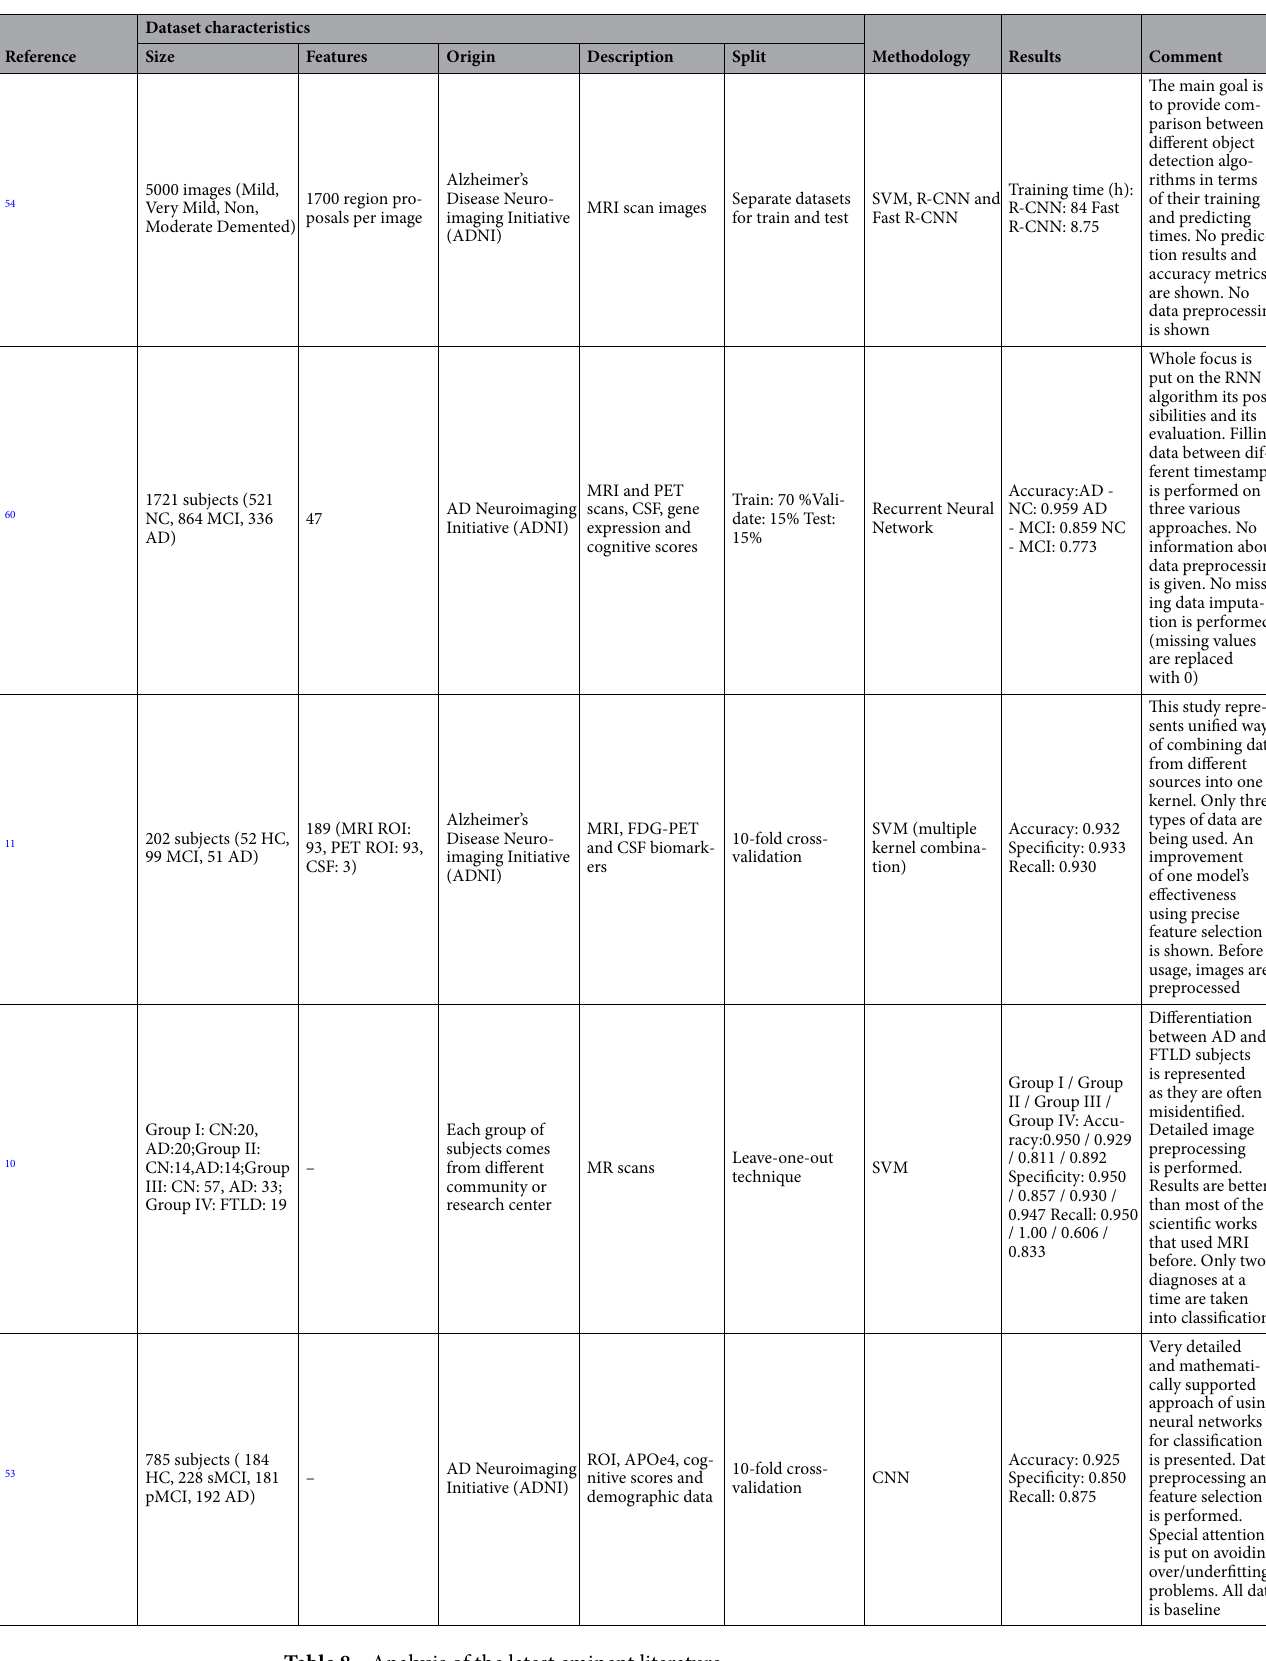
Table 8. Analysis of the latest eminent